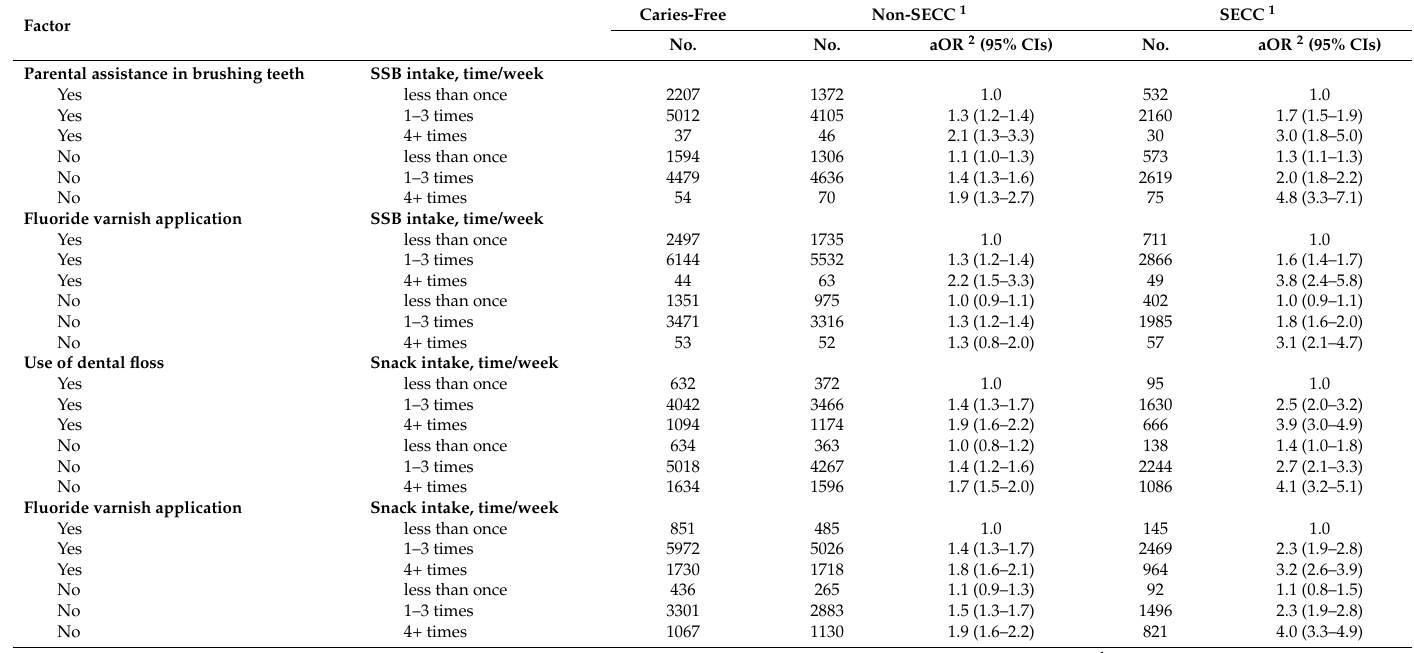
Caries-Free Non-SECC 1 SECC 1 No. No. aOR 2 (95% CIs) No. aOR 2 (95% CIs)